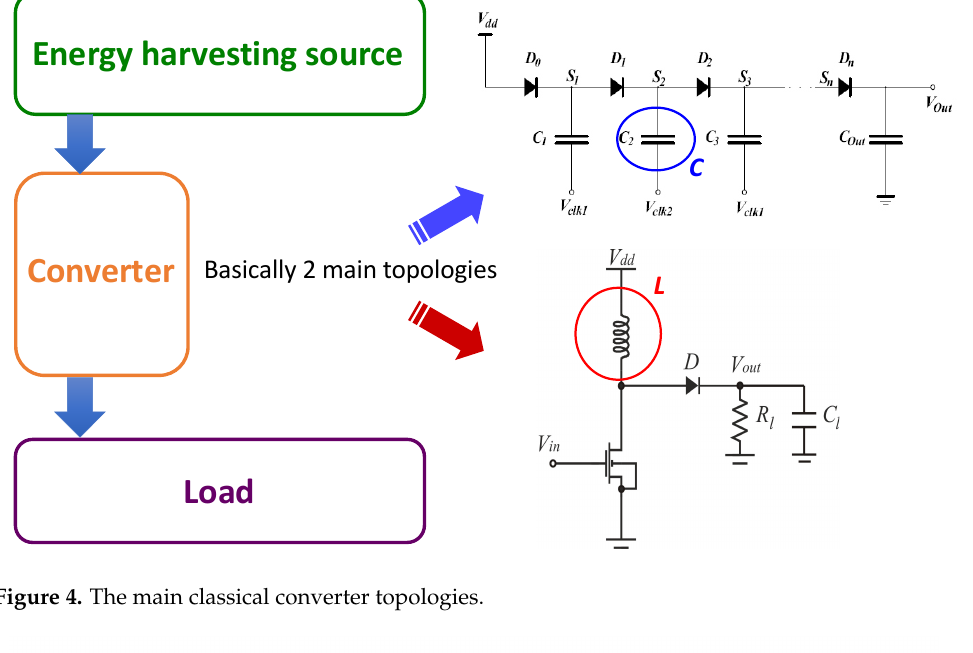
Figure 4. The main classical converter topologies.